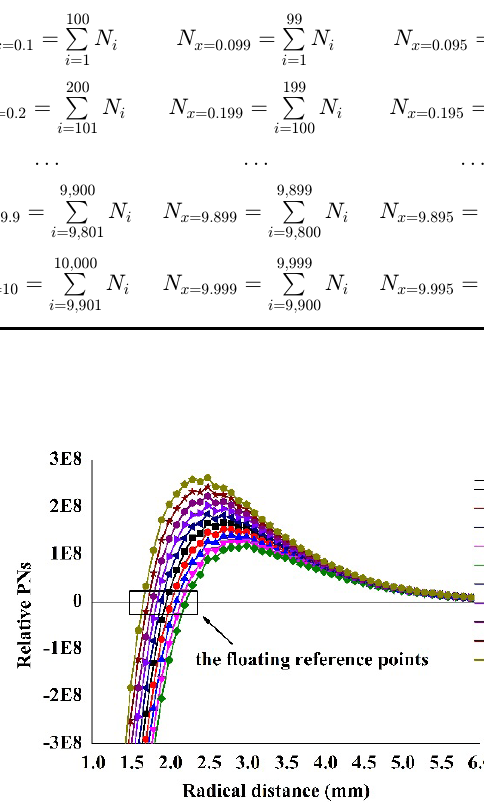
Fig. 5. The FRPs with positioning errors at di®erent direc- tions by